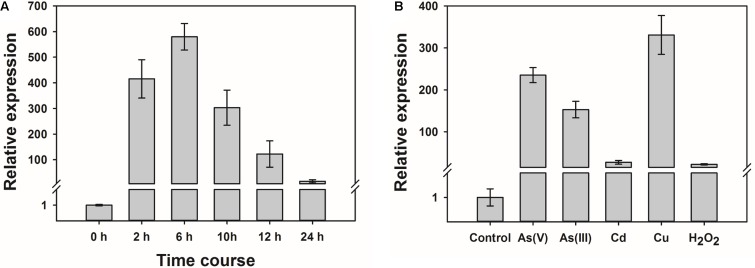
The expression of OsWRKY28 was responsive to arsenate and other oxidative stress. (A) Time course of the expression level of OsWRKY28 in roots. The plants were exposed to 1.5 μM As(V) without Pi supply for 24 h. (B) The transcript levels of OsWRKY28 exposed to other oxidative stresses for 12 h. The plants were exposed to 1.5 μM As5+, 20 μM As3+, 3 μM Cd, 2 μM Cu, 500 μM H2O2 without Pi supply. The relative expression of OsWRKY28 were normalized to the expression level at 0 h (A) or without treatment, respectively. OsHistone3 was used as the reference gene. Data are means ± SE (n = 3 biological replicates).